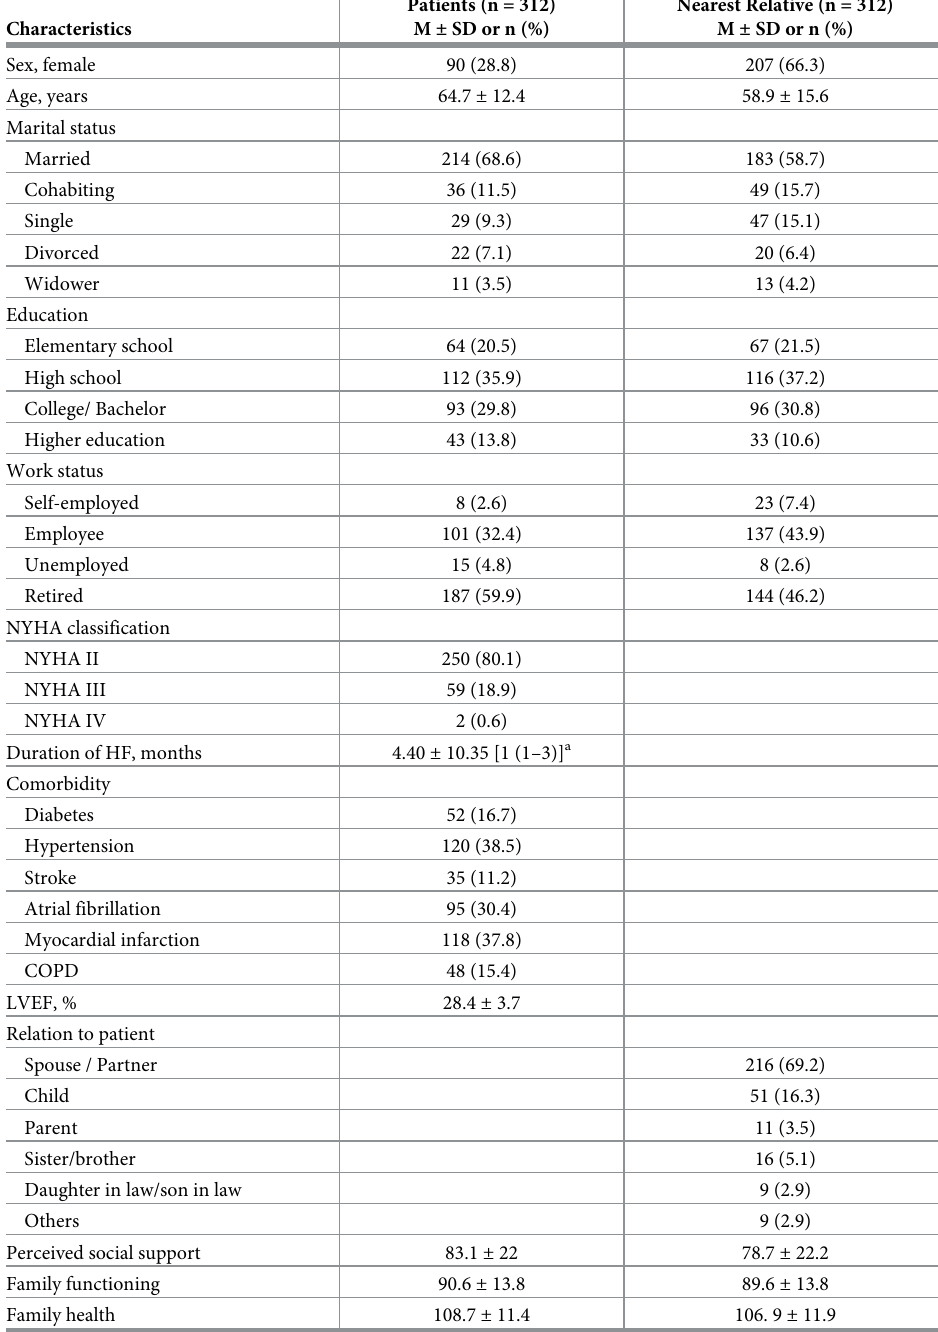
Table 3. Characteristics of patient–nearest relative